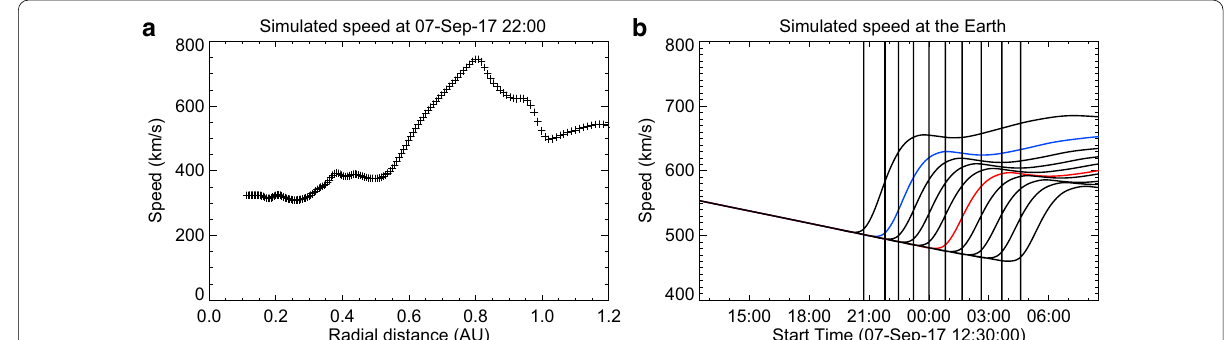
Fig. 2 Example of the simulated solar wind speed. a An example of the simulated solar wind speed at each grid located along the Sun–Earth line. b Solar wind speed at the Earth derived by simulation runs with CMEs with an initial speed derived from CACTus max speed (blue), the LASCO catalog (red), and eight CMEs with initial speeds that are faster or slower than the CME speed in the LASCO CME catalog with a 100-km/s interval (black). Vertical line indicates the arrival time of each CME at the